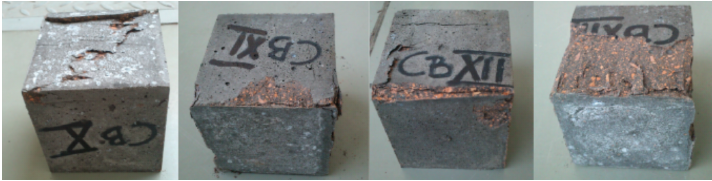
Figure 8. Damage samples BC.